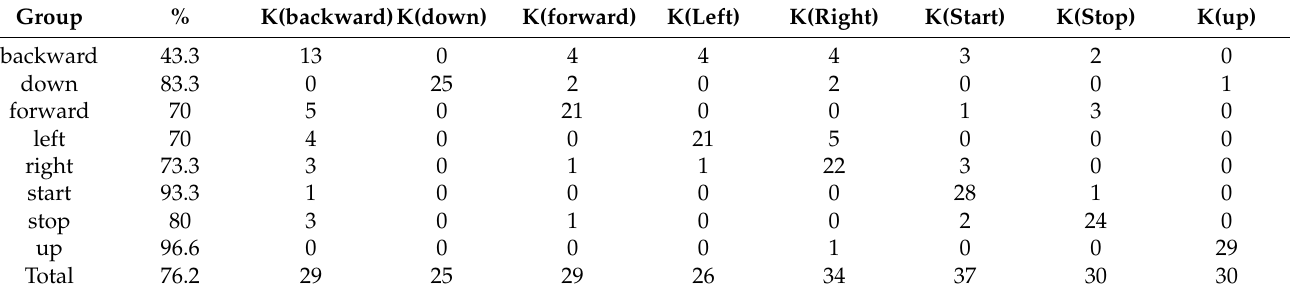
Table 4. The classification